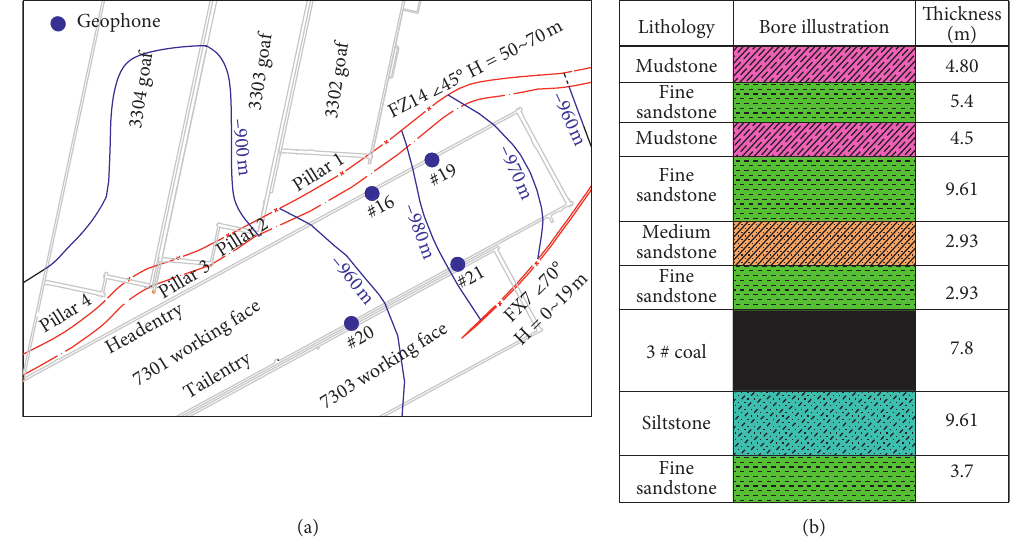
Figure 1: The plane layout of the 7301 working face and lithology of coal and rock strata. (a) The plane layout of the 7301 working face. (b) Lithology of coal and rock strata.